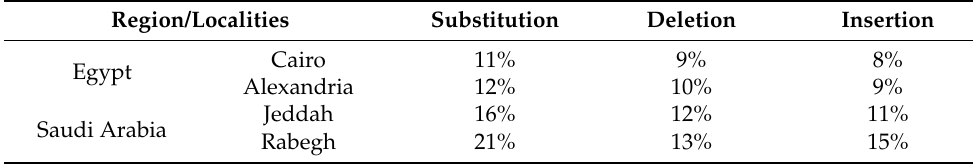
Table 5. Regions and localities for WER. Region/Localities Substitution